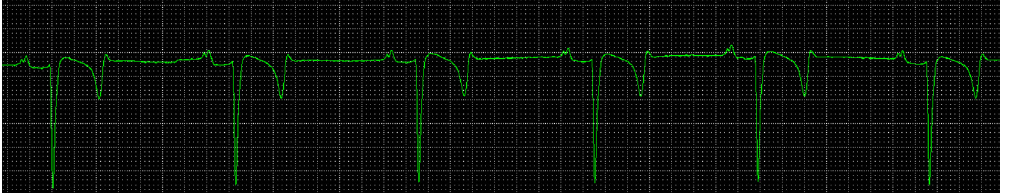
Figure 3. Electrocardiogram, donkey, male, 6 years old, base-apex plane, rS pattern and bifid P waves.